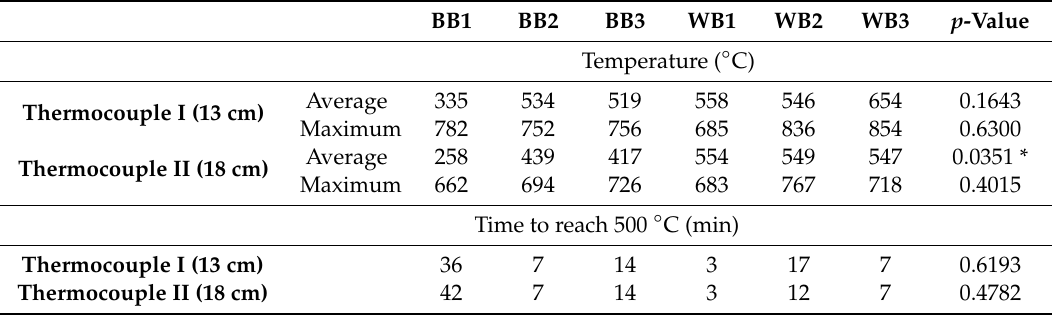
Table 2. Summary of temperatures and time to reach 500 ◦ C in a TLUD stove, during preparation of biochars from bamboo (BB) and pinewood